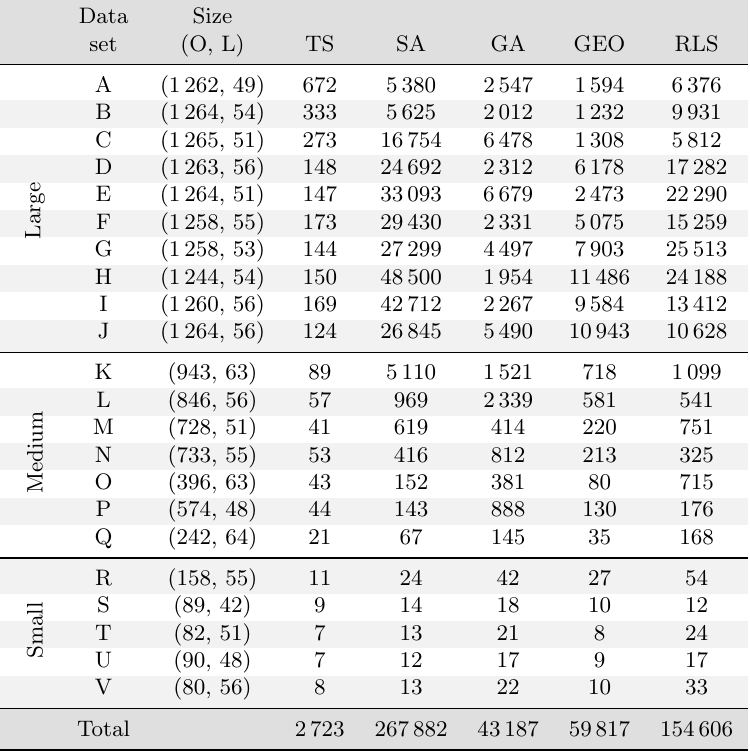
Table 2: Computational times in milliseconds for the results in Table 1. The number of orders (O) and the number of locations (L) are indicated for each data set. The results of the tabu search (TS), simulated annealing (SA), genetic algorithm (GA), generalised extremal optimisation (GEO) and random local search (RLS) are